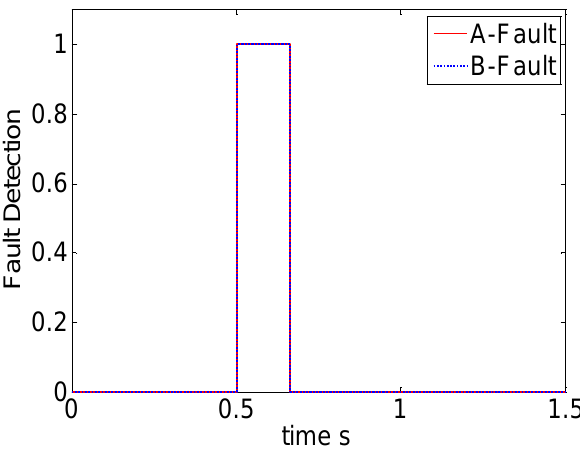
Figure 11. Fault detection signal for case 3, scenarios A and B.